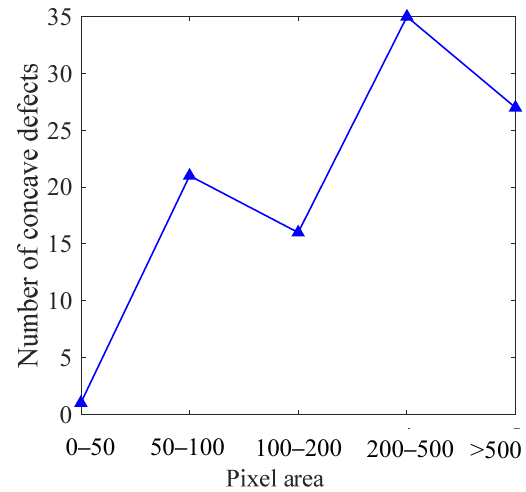
Figure 4. Area distribution of concave defect pixel.